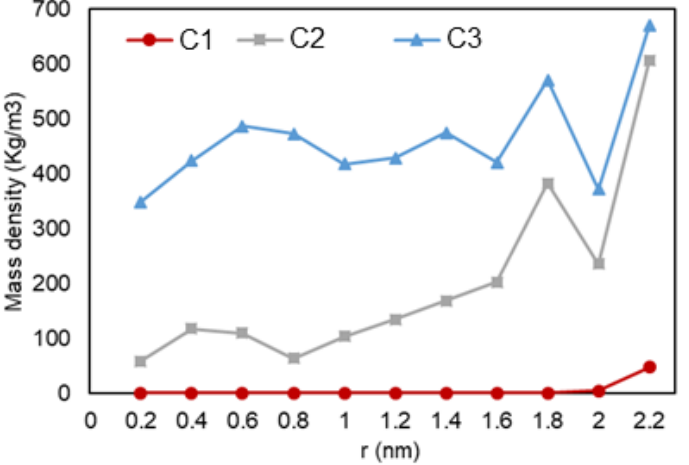
Figure 5. Ethane mass density vs. radial position in C1 (gas phase in bulk), C2 (two-phase in bulk), and C3 (liquid phase in bulk) conditions.